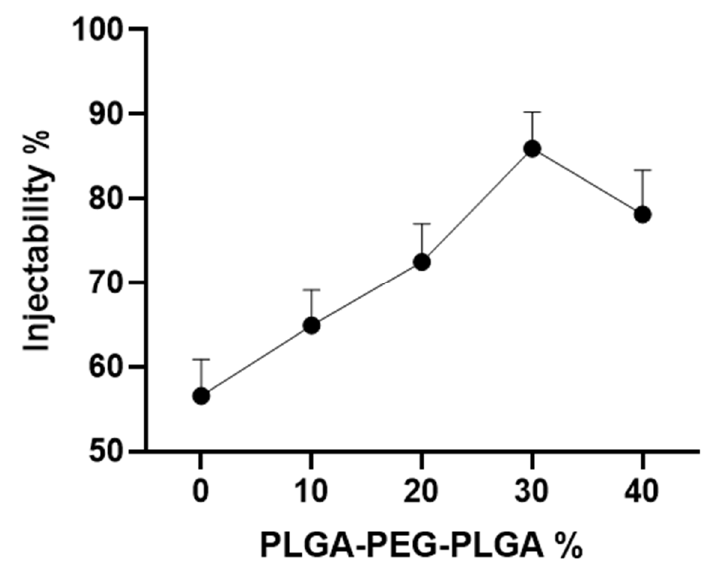
Figure 6. Injectability of composite bone cement with different PLGA-PEG-PLGA thermosensitive hydrogel contents.